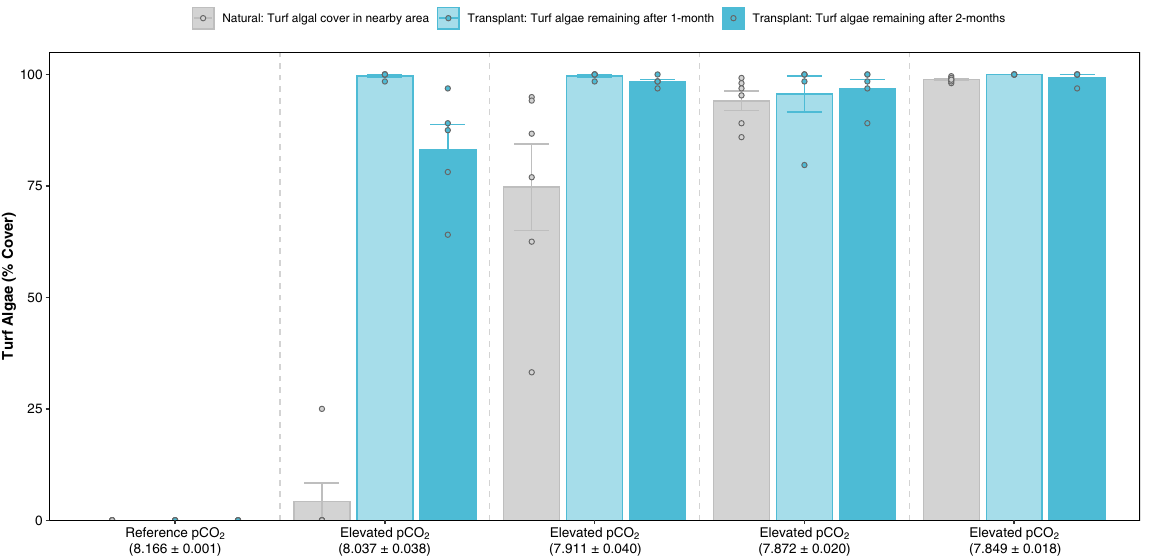
Fig. 8 Reverse threshold of turf algae transplanted back along the pH gradient compared to their natural percentage cover. Natural turf algal cover (grey) and turf algal assemblage remaining following a 1-month (light blue) and 2-month (dark blue) transplant of pre-established (fully covered) turf algal assemblage tiles into each site (indicated by their mean pH NBS ± S.E.). Natural turf algal cover ( n = 6 biologically independent measurements at each